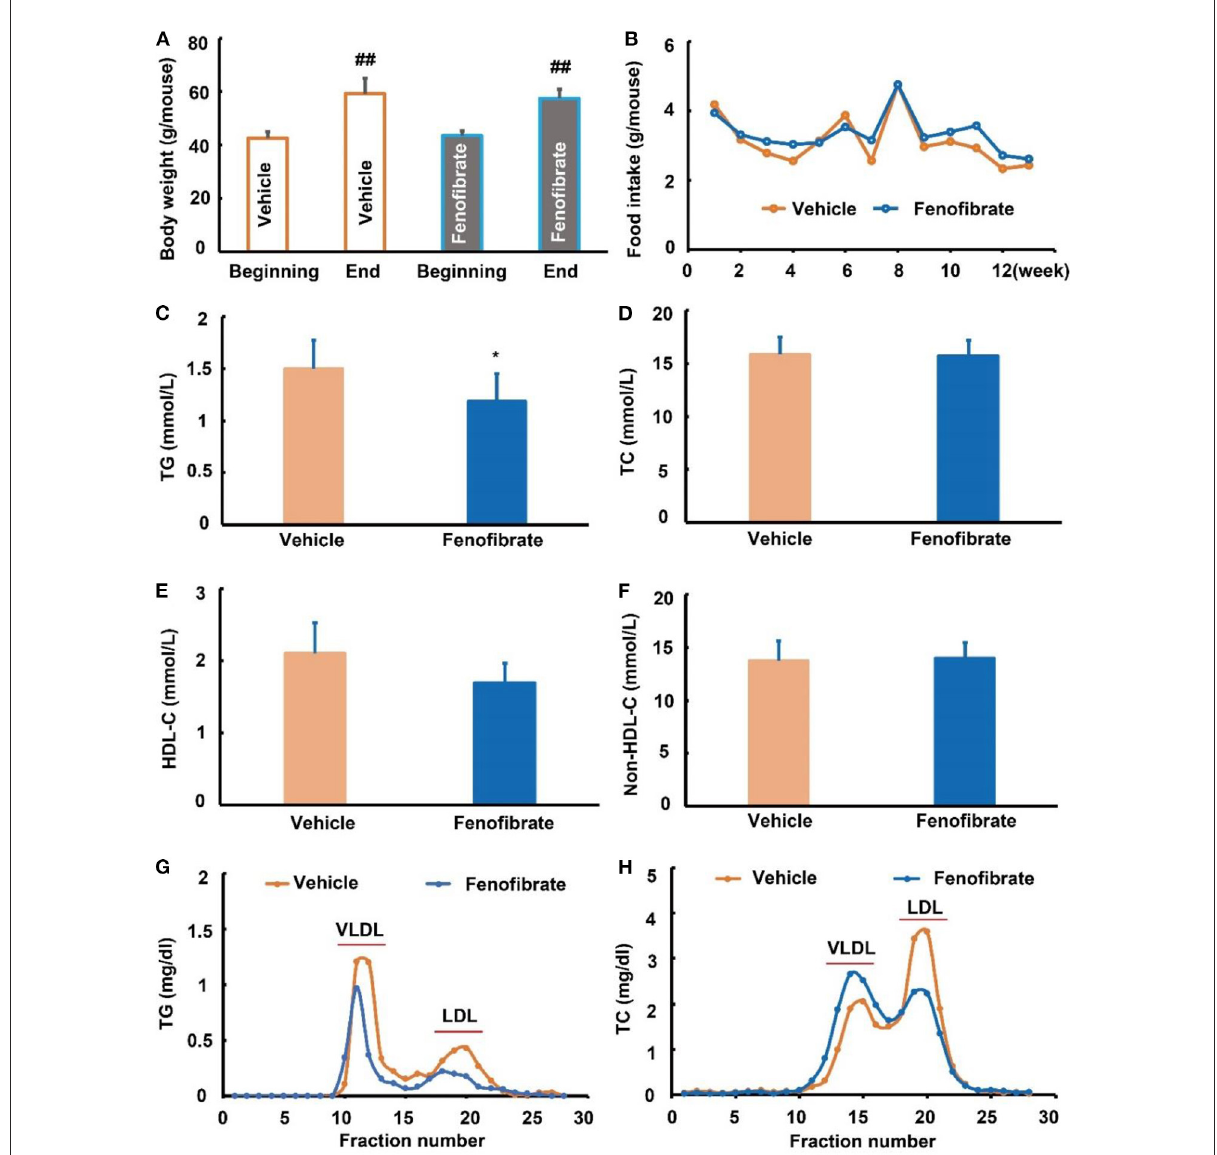
FIGURE1 Effect of fenofibrate on the body weight, food intake, and lipid profiles of the ob/ob mice. (A) body weight of the mice at the beginning and end of the study; (B) food intake of mice in each group; (C) plasma triglyceride (TG) levels; (D) plasma total cholesterol (TC) levels; (E) plasma high density lipoprotein cholesterol (HDL-C) levels; (F) plasma non-HDL-C levels; (G) plasma TG profiles of very low-density lipoprotein (VLDL) and low-density lipoprotein (LDL) fractions after ÄKTA fast protein liquid chromatography (FPLC) separation; (H) plasma TC profiles of VLDL and LDL fractions after ÄKTA FPLC separation. Data were expressed as mean ± SD, and the statistical analysis was performed by Student- t -test. ## means significantly different at p < 0.01 vs. the beginning body weight of the mice; * means significantly different at p < 0.05 vs. Vehicle group. Vehicle: mice were treated with 0.5mL of water by gavage for 13 weeks ( n = 7); Fenofibrate: mice were treated with 0.5mL of fenofibrate suspension liquid at the dose of 20 mg/kg/d by gavage for 13 weeks ( n = 8).